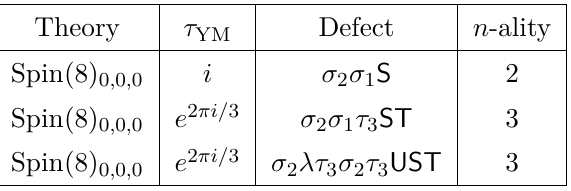
Table 9 . Non-invertible symmetries of Spin(8) 0 , 0 , 0